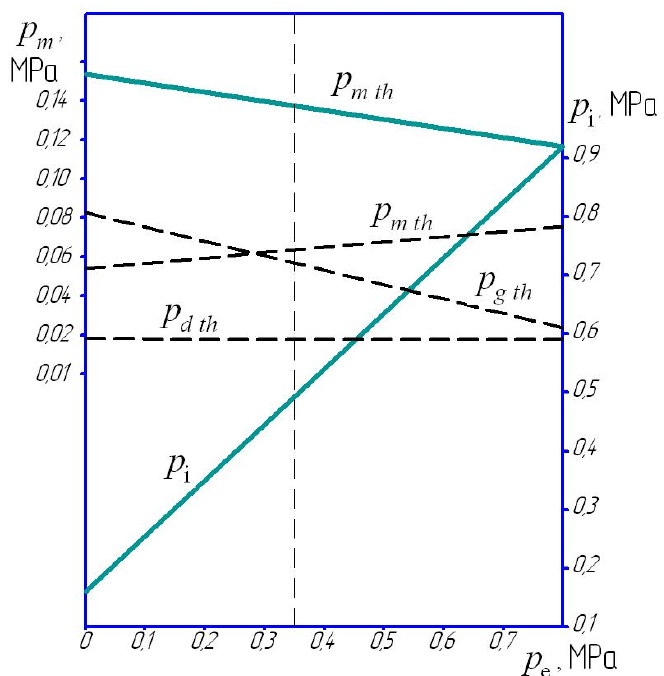
Figure 2. The dependencies of engine parameters on average effective pressure during throttling ( n = 1800 rpm).